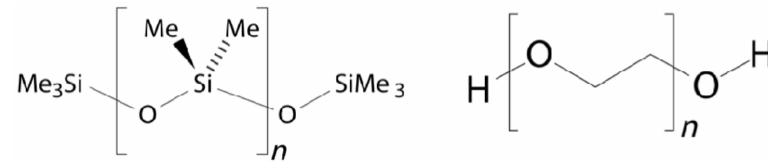
Figure 7. Chemical structures of PDMS (left) and PEG (right).